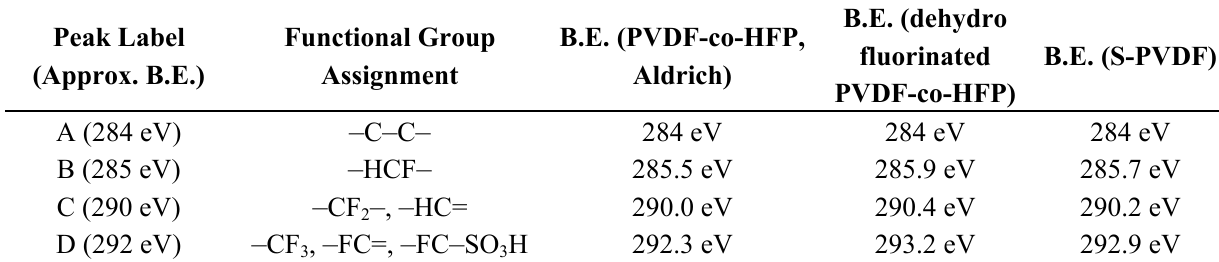
Table 2. Binding energy assignments in high-resolution C1s XPS.